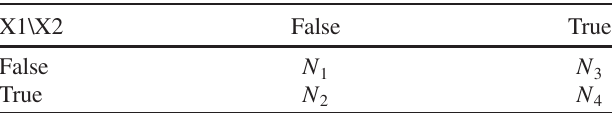
TABLE I. Contingency